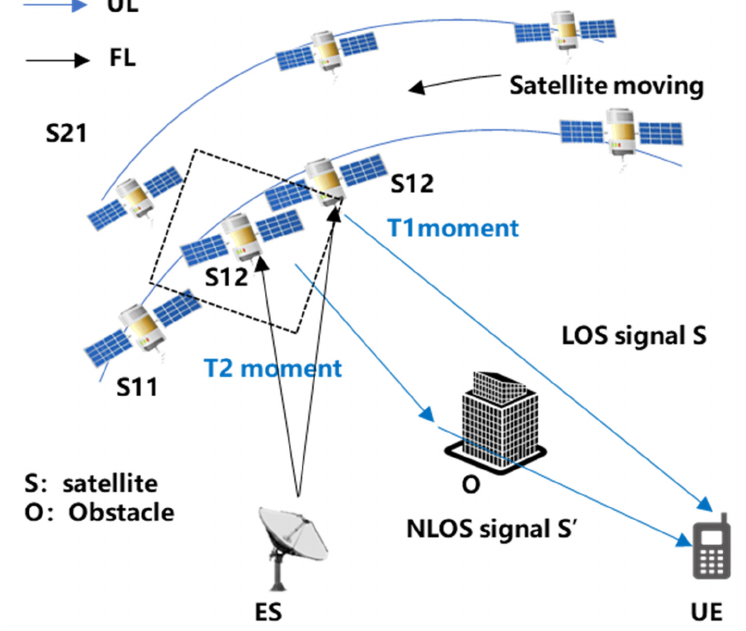
Figure 2. System model of Low Earth Orbit Satellite Internet Network (LEO-SIN).